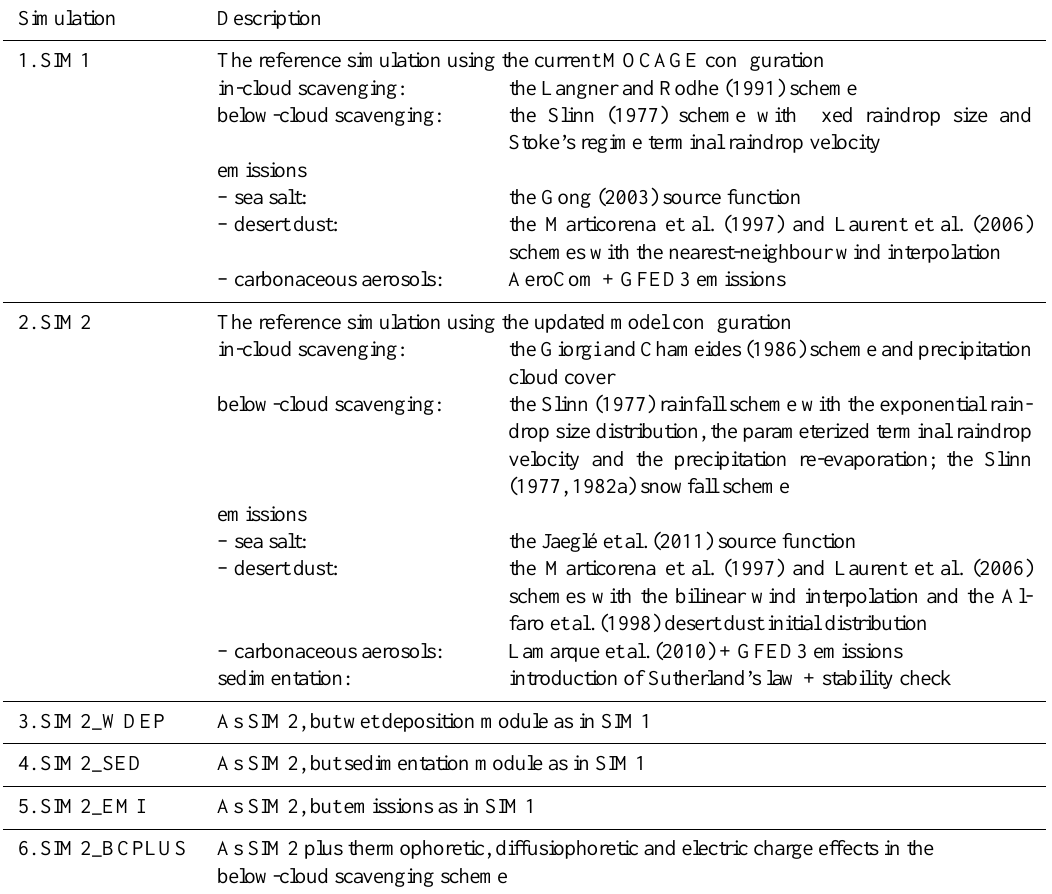
Table 2. Description of MOCAGE simulations used in this study. Simulation